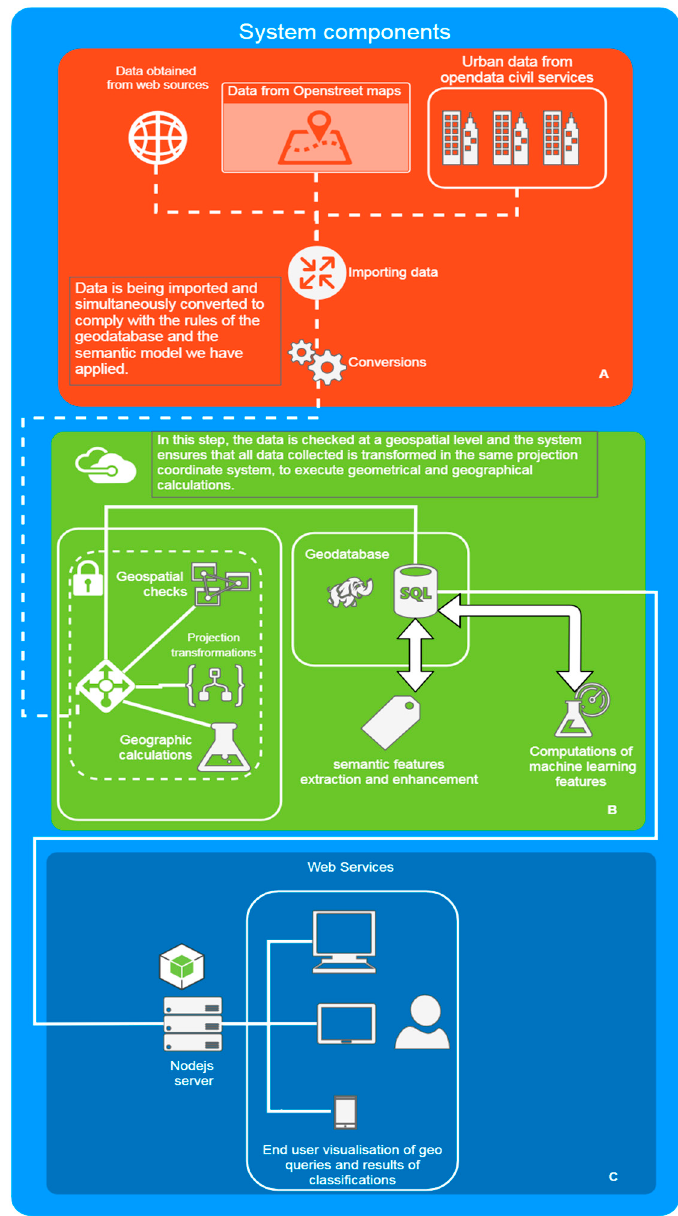
Figure 3. Functional Block Diagram of the proposed System.